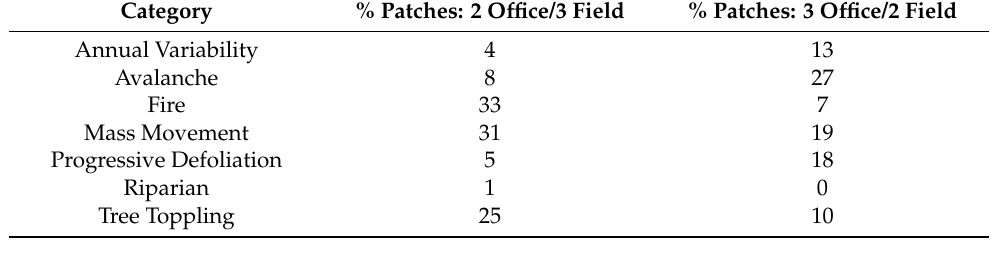
Table 6. Comparison of high and medium confidence levels by change category.